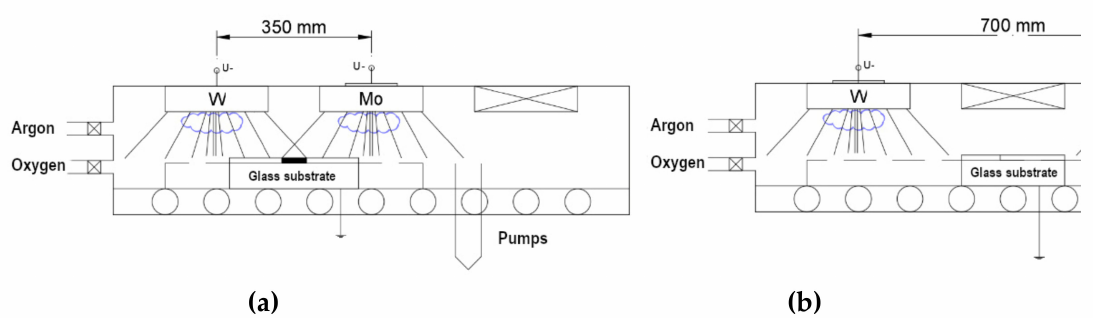
Figure 1. Two arrangements of the targets: ( a ) The two targets in closer position (35 cm from each other); ( b ) the two targets in distant position (70 cm from each